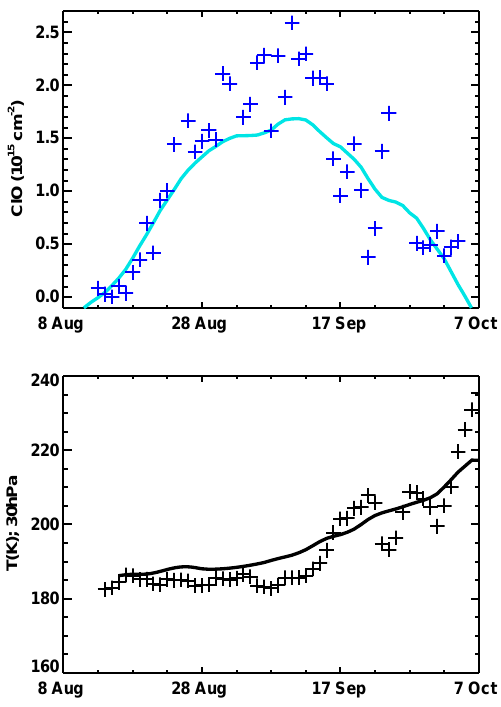
Figure 6. Top panel: daily (day minus night) ChlOE1 column den- sity measurements for mid-August to mid-October 2000 (crosses) and a climatology for that period based on the ChlOE measurements from 1996 to 2015 (solid line). Bottom panel: daily 30hPa tempera- ture from MERRA within ± 2 ◦ latitude and ± 15 ◦ longitude of Scott Base (crosses) and a 1996–2015 climatology for this location (solid line).